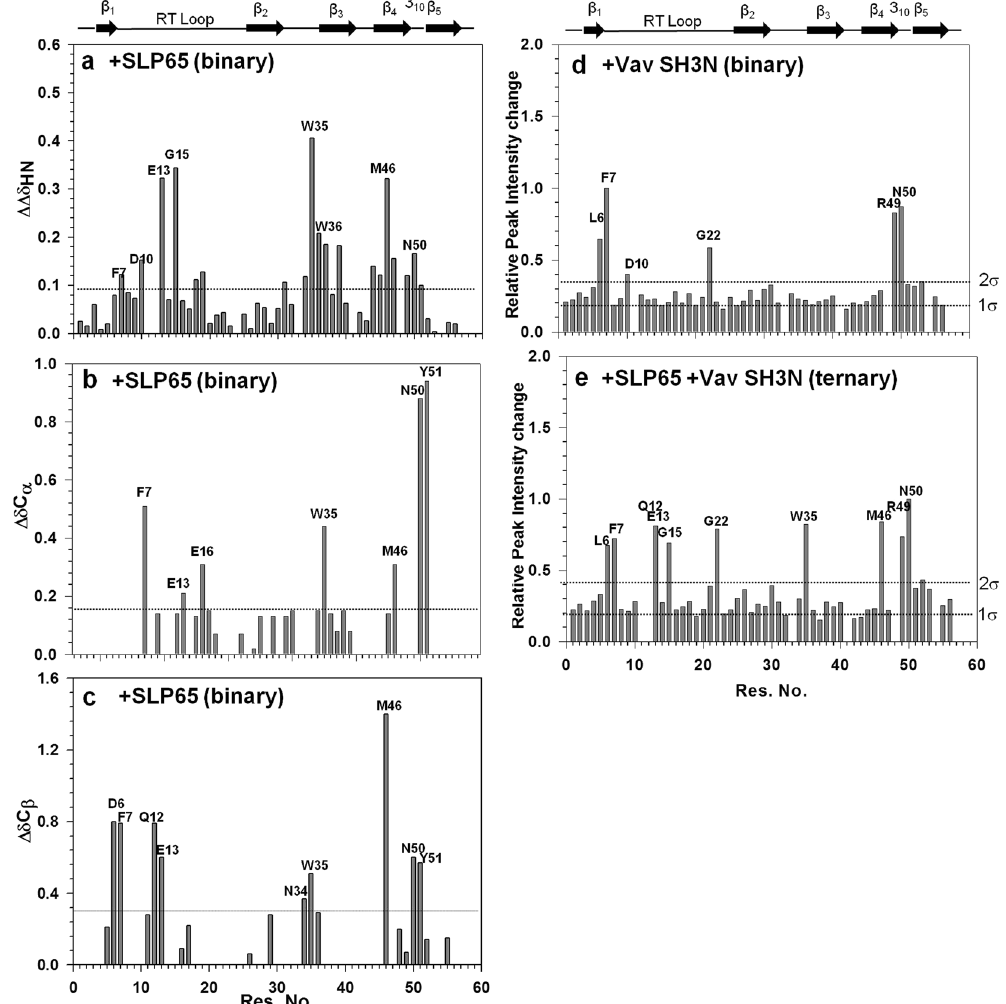
Figure 2. The interaction of Grb2 SH3C domain with its ligands. Changes in the ( a ) Average amide, ( b ) C α , and ( c ) C β chemical shifts of Grb2 SH3C domain upon binding the SLP65 peptide. Changes in the ( d ) peak intensities of the Grb2 SH3C amides upon binding Vav SH3N domain in the binary complex, ( e ) peak intensities of Grb2 SH3C amides upon binding Vav SH3N domain in the trimeric complex. The binding studies were carried out in 20 mM Sodium Phosphate buffer, 100 mM NaCl, pH 6.0, 25 °C. A discontinuous horizontal line in the figure marks one or two standard